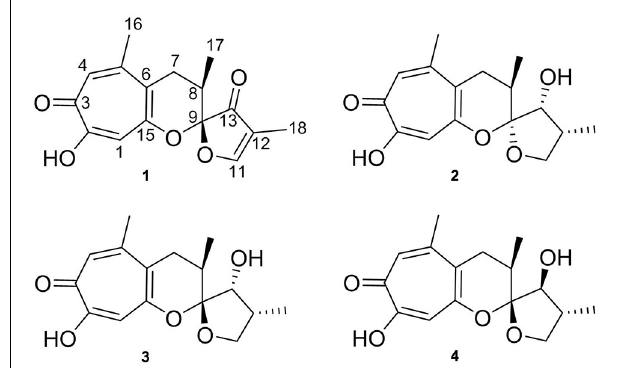
FIGURE 1 | Structures of malettinins A–C (1–3) and malettinin E (4), isolated from Cladosporium sp. strain KF501.